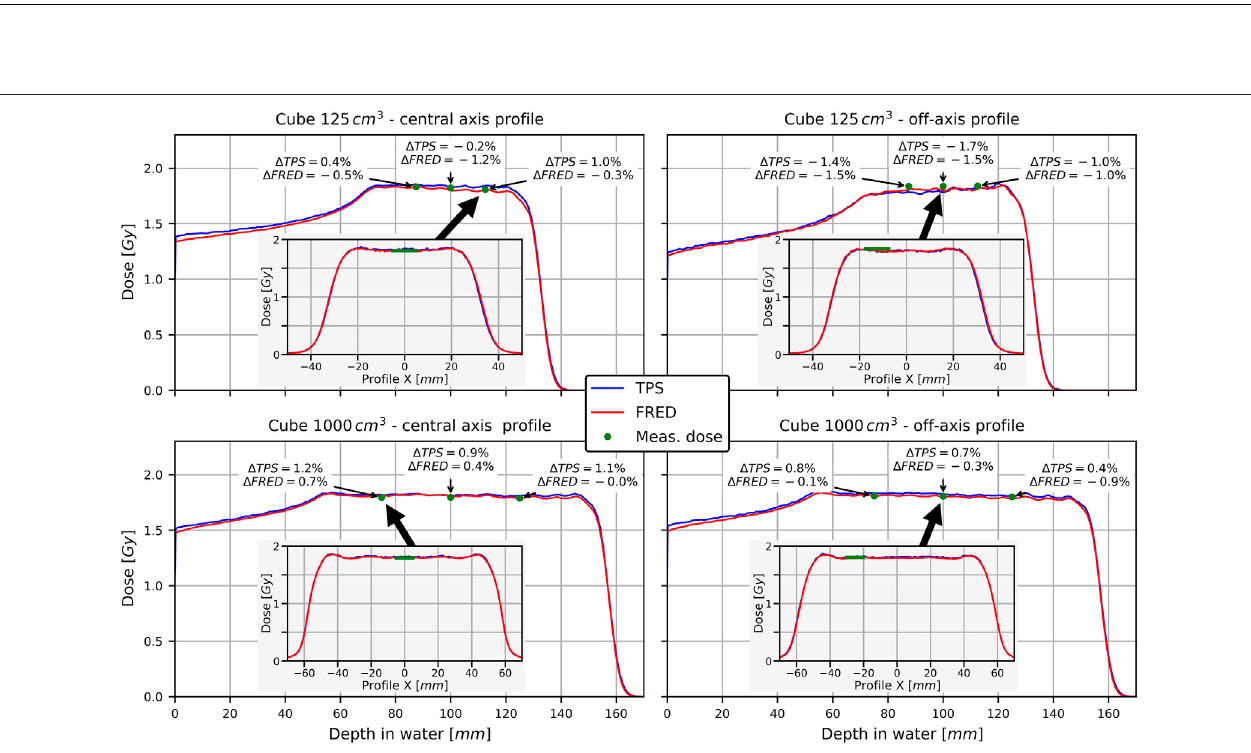
FIGURE 7 | Longitudinal pro fi les across dose cubes along the central axis (left) and off-axis (right) . The inlays show transverse pro fi les at the depth indicated by the arrow. Annotation boxes show relative difference between F RED /TPS and measurement at the indicated points.